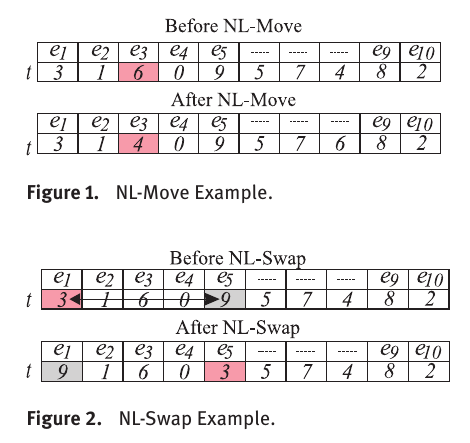
. x ′ Figure 3 shows the example of the NL­KempeChain i